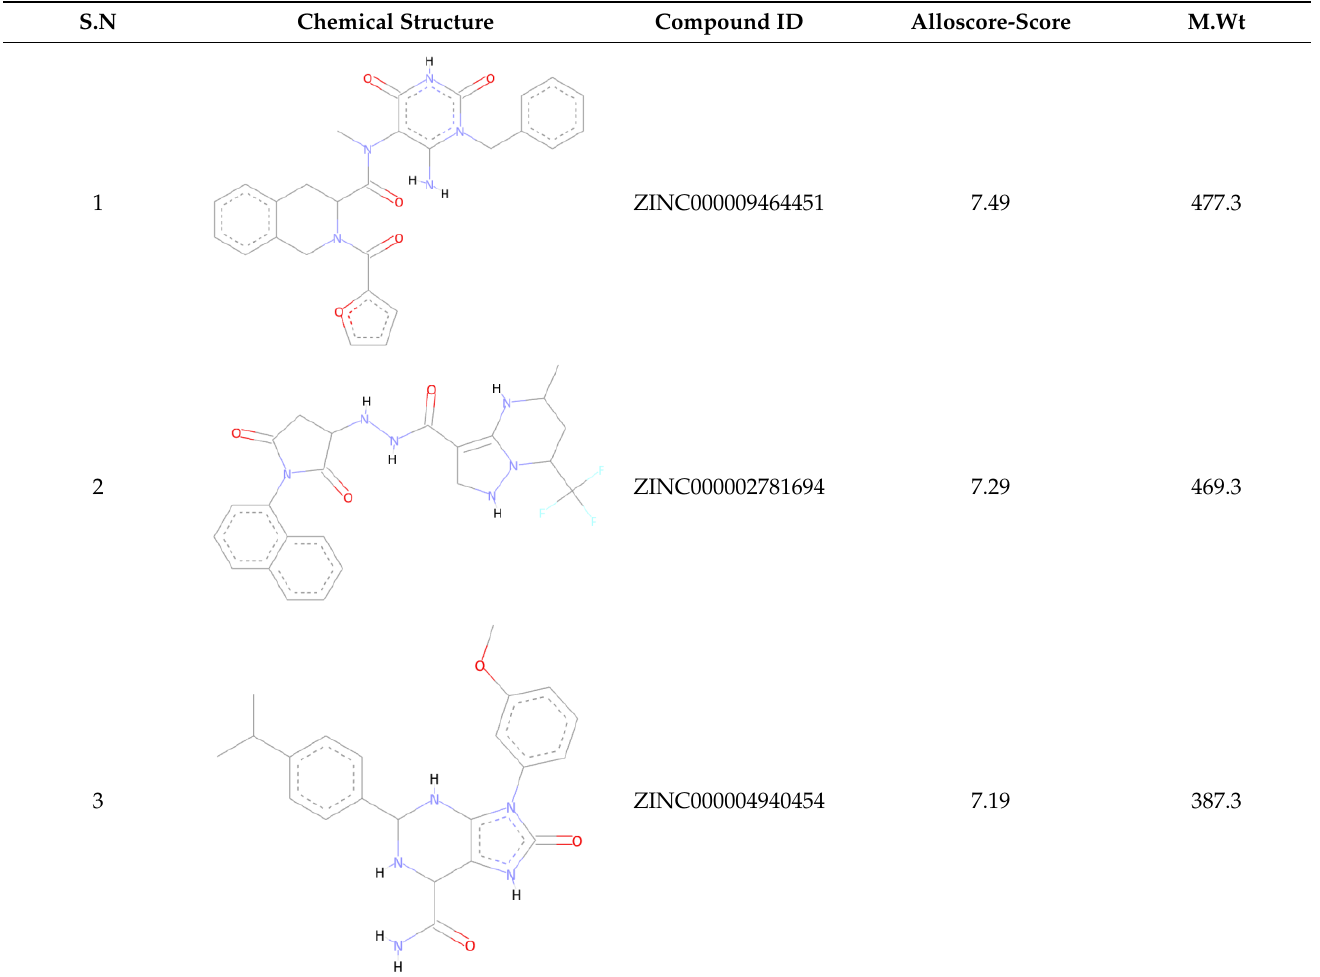
Table 2. Chemical structures, compound IDs, their Molecular weights and alloscore-score ranking from ZINC Diversity Library.